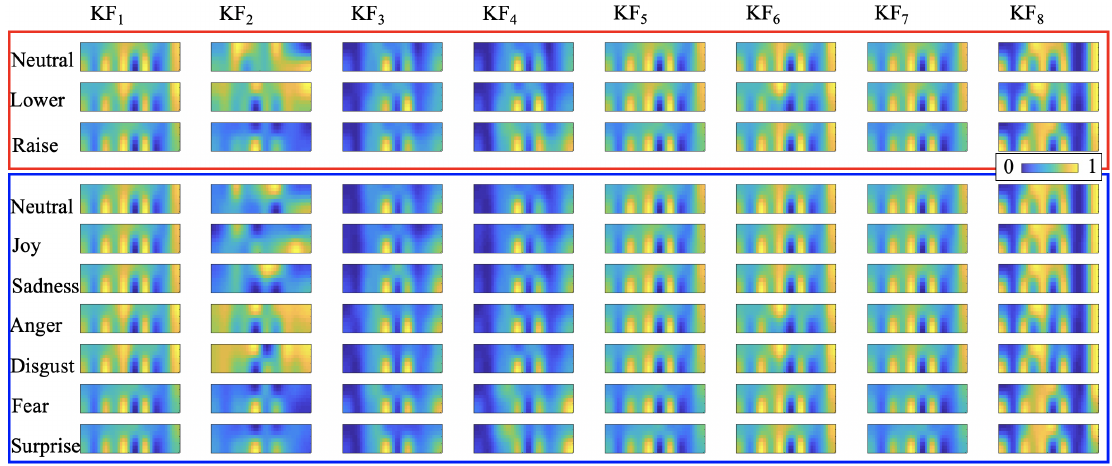
Figure 5. Key frames examples from a single participant (participant